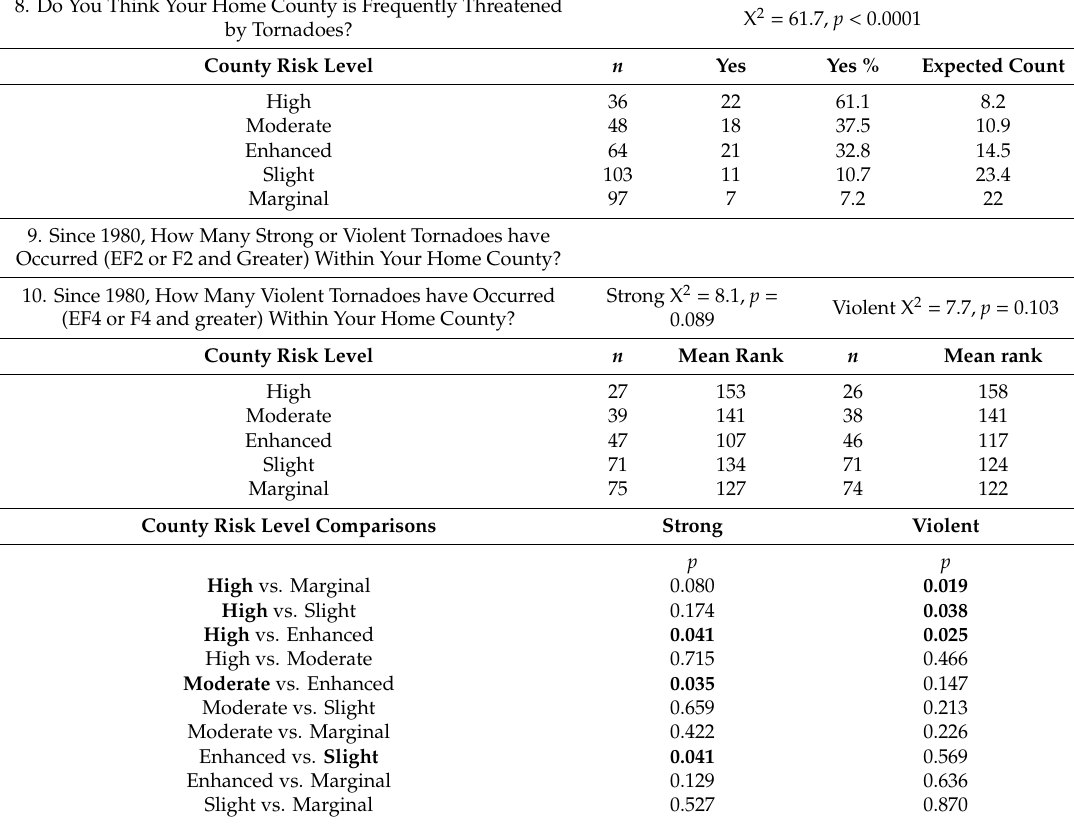
Table 3. Question 8 (Top): Chi square results for each county risk level perception of being frequently threatened. Question 9 and 10 (Middle): Strong and violent tornado perception. (Bottom): Mann Whitney paired comparisons between county risk level categories. Bold = significantly greater numbers at the 0.05